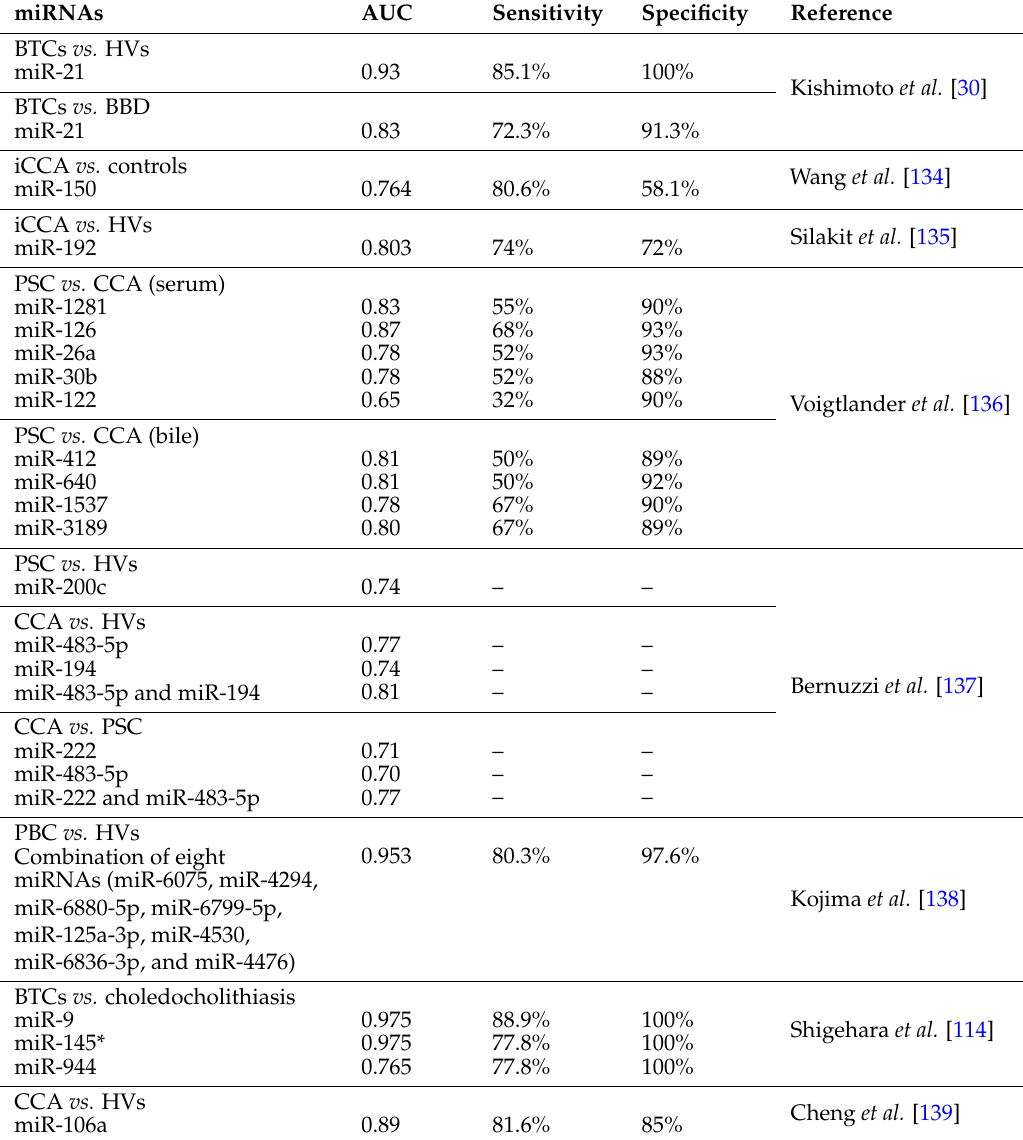
Table 1. Area under the curve (AUC), sensitivity and specificity values of miRNAs in plasma and bile samples, according to different histological conditions of biliary tract cancers. miRNAs